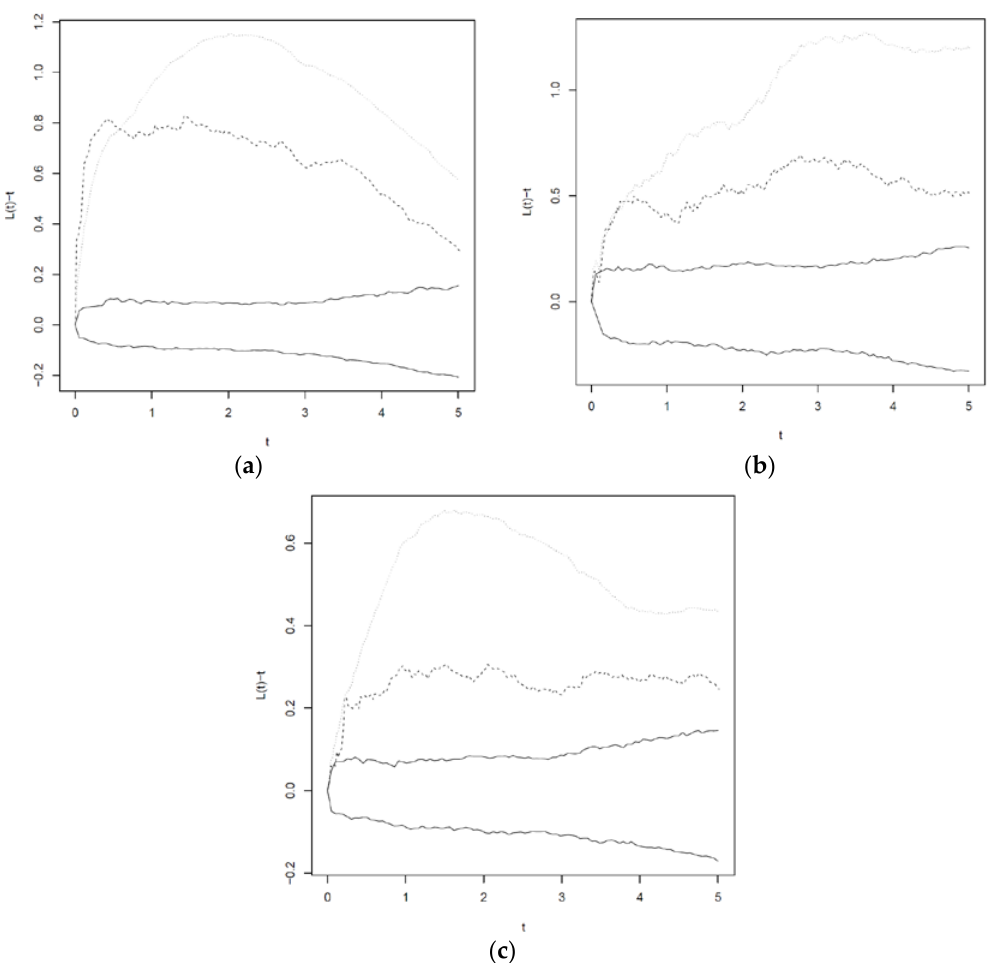
Figure A1. L-functions for F. sylvatica ( a ), P. abies ( b ) and A. alba ( c ) . Dotted curves: L(t)-t computed assuming constant intensity. Dashed: L(t)-t computed assuming inhomogeneous intensity. Solid curves: 95% envelopes for L(t)-t assuming an inhomogeneous Poisson process. For an inhomogeneous Poisson process, the expected value of L(t)-t is zero.